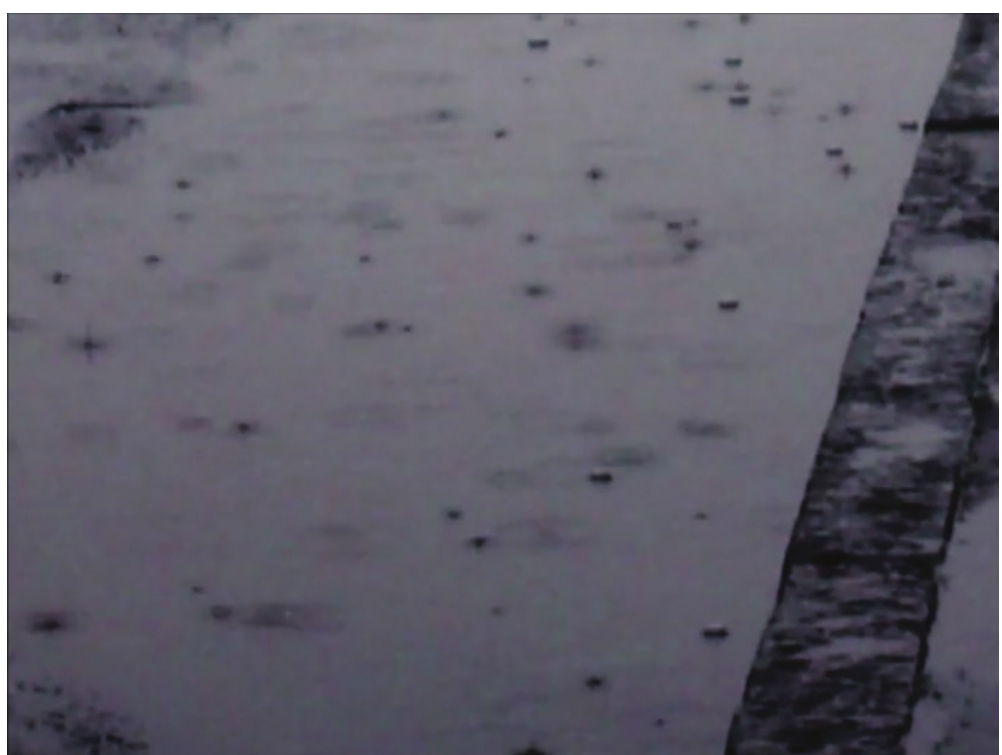
Figure 2: Weather as an expressive cinematic modality in Get Over